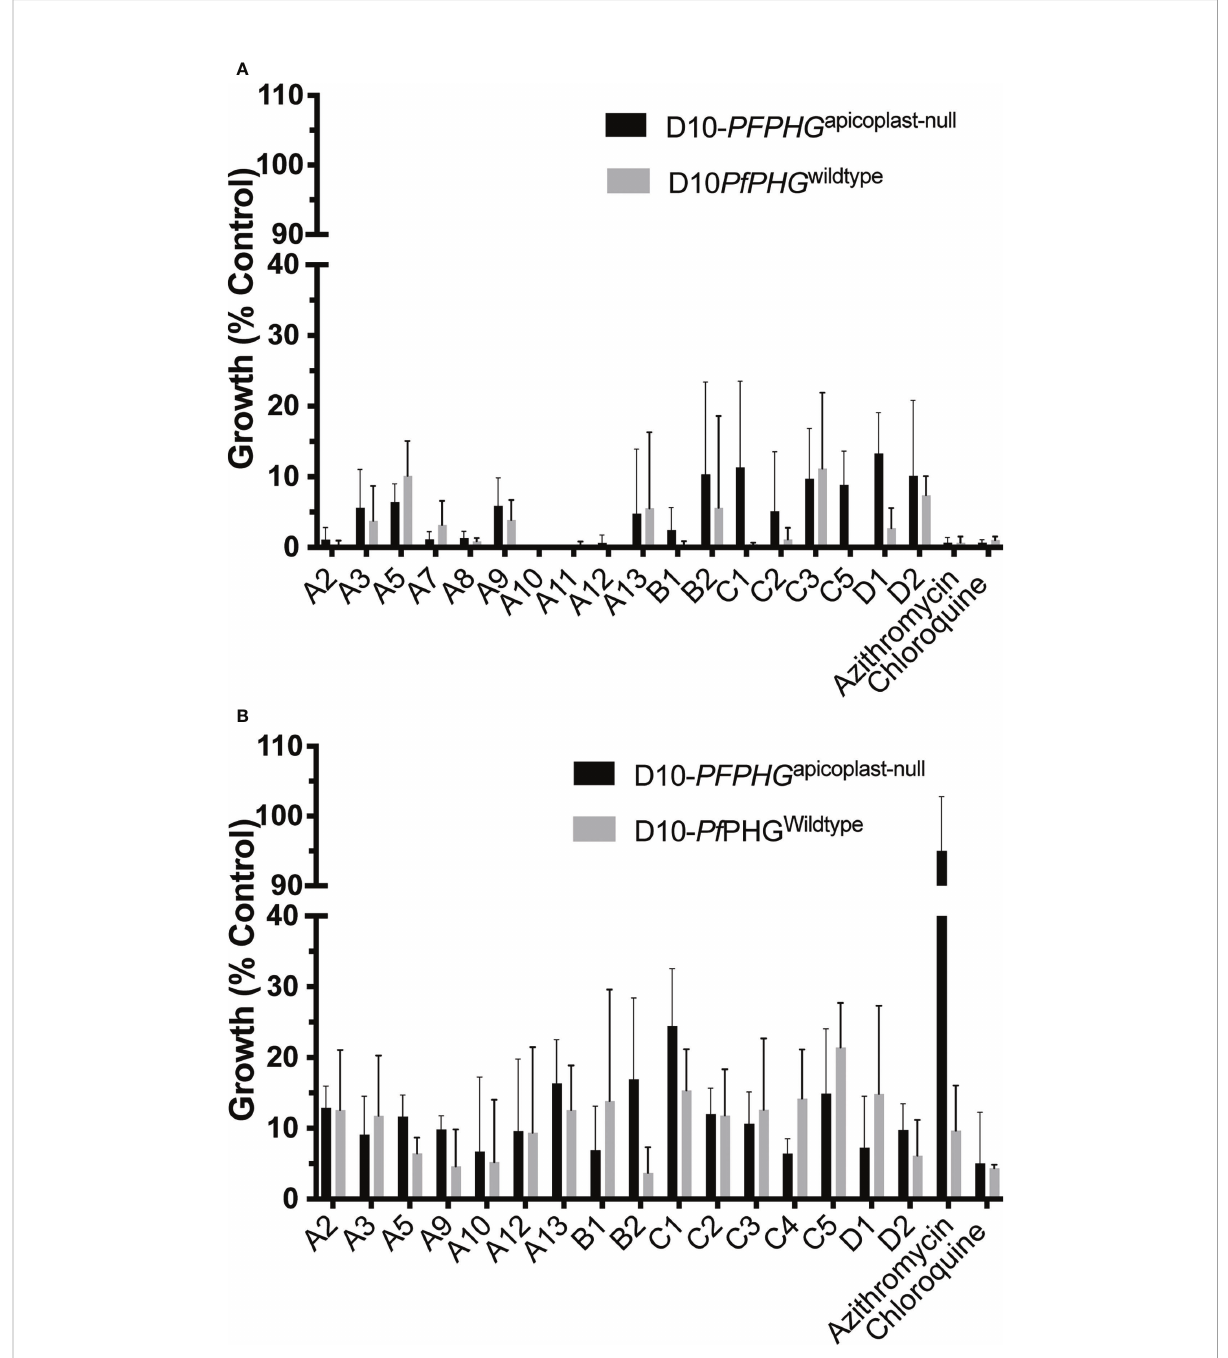
FIGURE 3 Activity of azithromycin analogues in the presence or absence of the apicoplast. Early ring-stage D10-PfPHG wildtype (no IPP) (grey bars) or D10- PfPHG apicoplast-null (+IPP) (black bars) P. falciparum parasites (0-4 hrs post-invasion) were treated with: (A) the IC 90 of in cycle growth inhibition, addition of IPP did not rescue parasite growth from quick-killing activity of azithromycin or analogues, and (B) the IC 90 of 2 cycle (delayed- death) growth inhibition, IPP rescued parasite growth from azithromycin ’ s delayed death activity (inhibitor of the apicoplast ’ s bacterial-like ribosome) but did not rescue parasite growth from chloroquine (targets the digestive vacuole) or analogues. Parasitemia was measured at 44 hr or 120 hrs post invasion at schizont stage via fl ow cytometry for in cycle and delayed death assays, respectively. Data represents the means of 3 (or more) experiments expressed as percentage of non-inhibitory control and error bars represent the ±